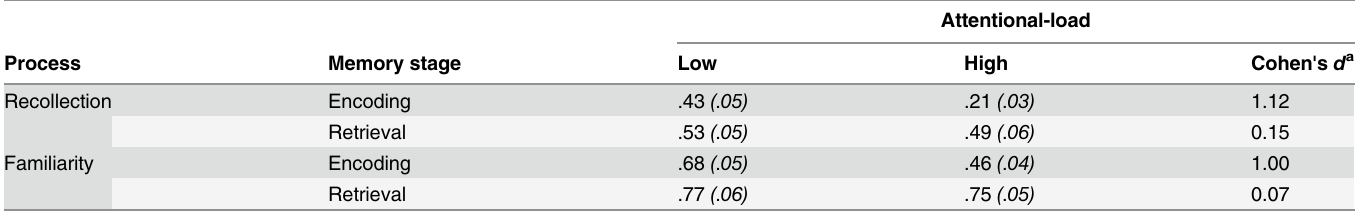
Table 3. Experiment 3. Mean estimates (and SE) of Recollection and Familiarity hit rates, as a function of Attentional-load (High, Low) and Memory stage (Encoding,